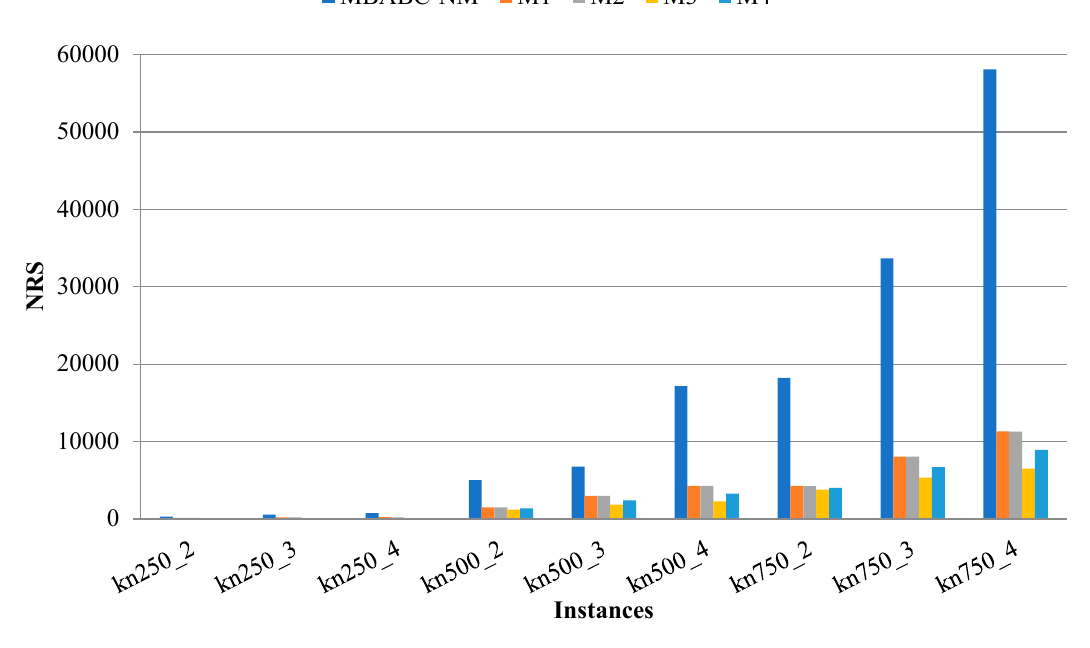
Figure 2. Performance of MBABC-NM w.r.t NRS.